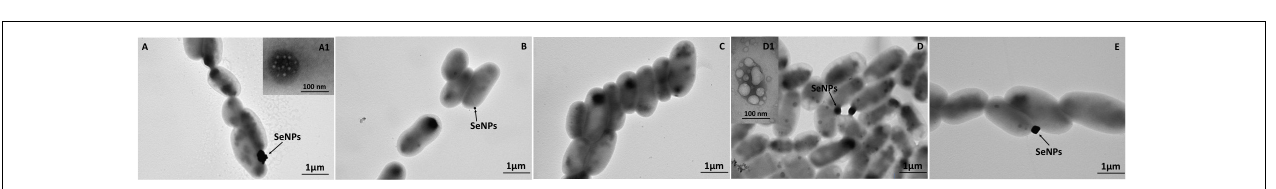
FIGURE 5 | Time course imaging by TEM of Ochrobactrum sp. MPV1 strain grown in DM amended with pyruvate (0.5% v/v) and SeO 2 − 3 (0.5 mM) for 24-h (A) , 48-h (B) , 72-h (C) , 96-h (D) , and 120-h (E) . The inlets (A1,D1) show intracellular inclusions. SeNPs are indicated by black arrows.